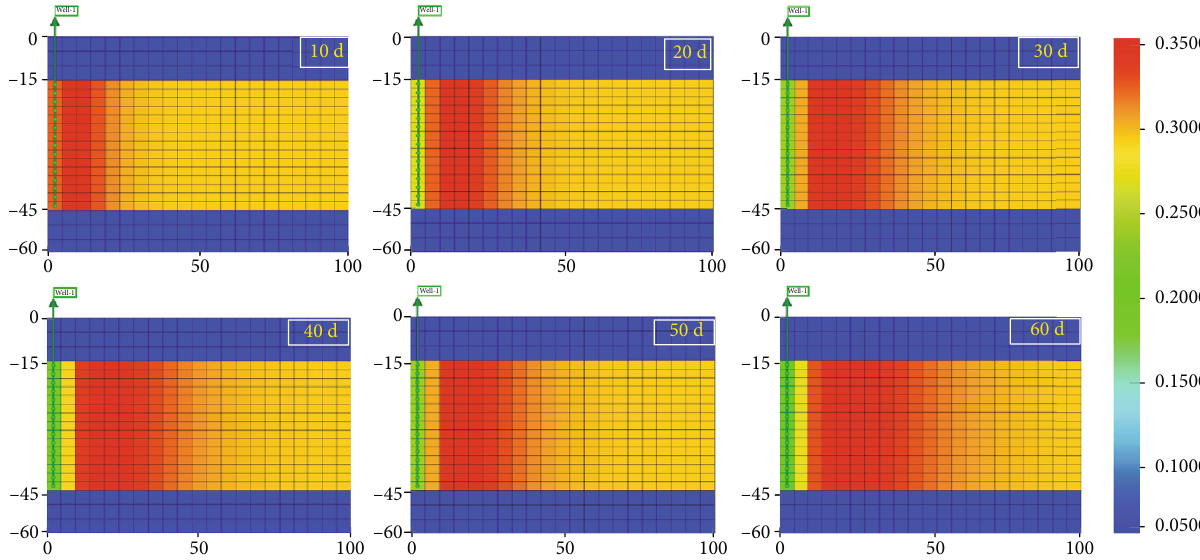
Figure 5: Evolution of spatial distribution of e ff ective porosity.